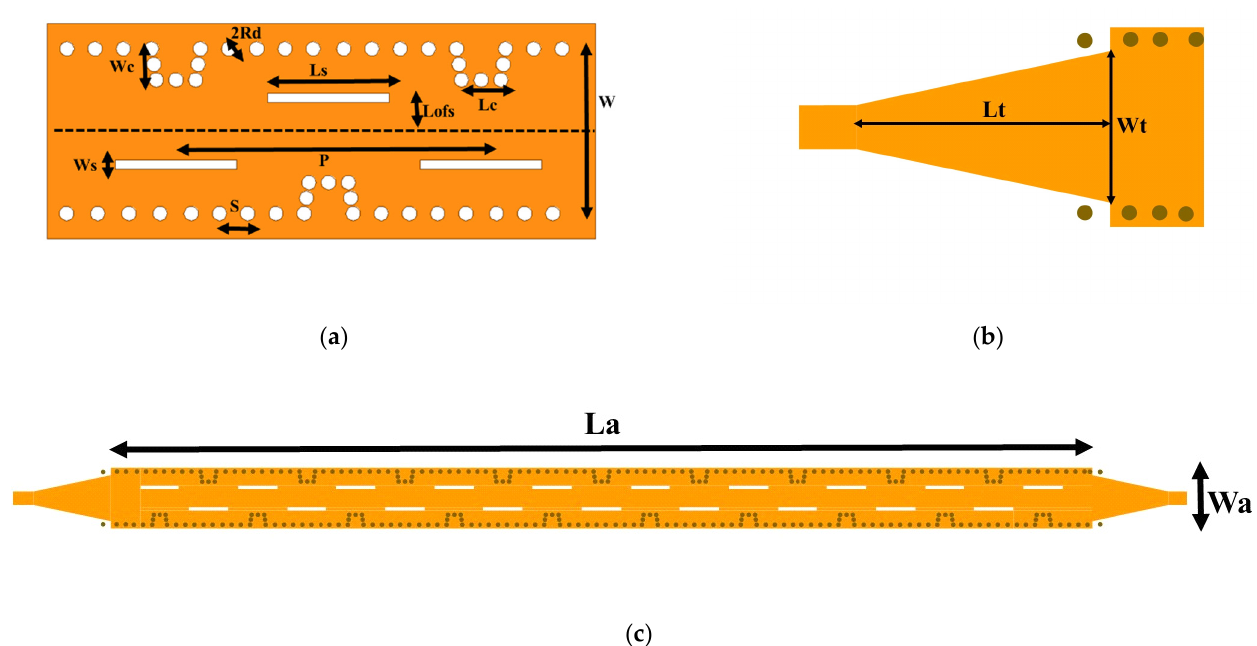
Figure 1. Proposed SIW LWA: ( a ) unit cell; ( b ) matching end; ( c ) array configuration [15]. Table 1. Parameters of the periodic SIW LWA.